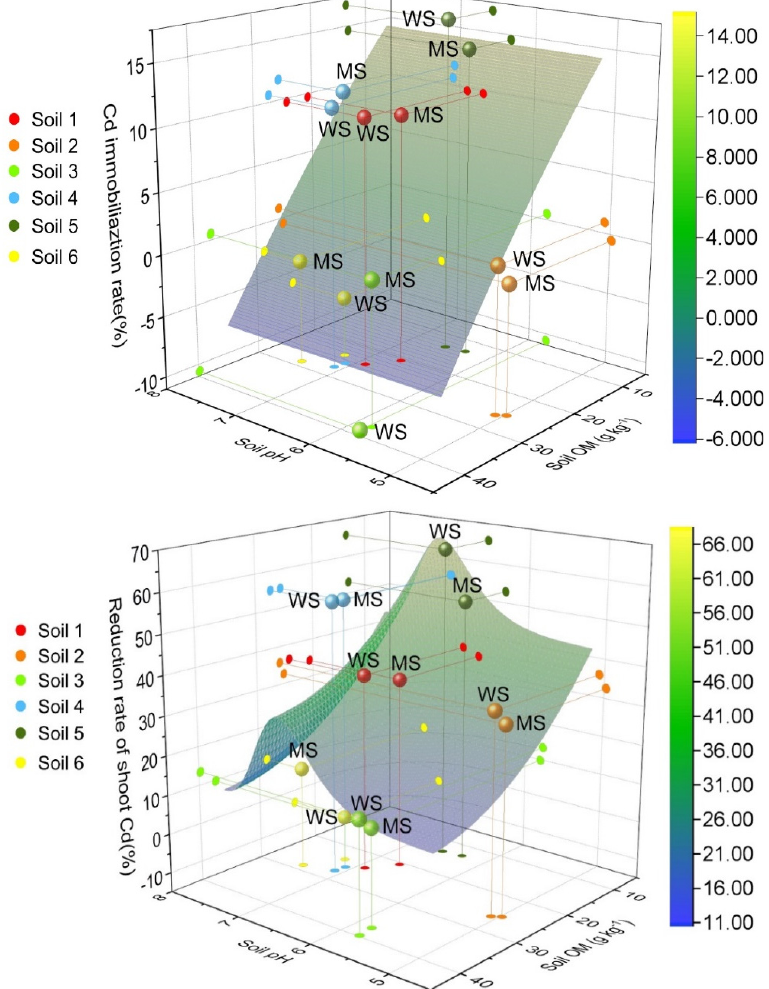
Figure 6. Response surfaces showing the interactive effects of soil pH and OM on Cd immobiliza- tion rate in six soils and reduction rate of shoot Cd by 4A molecular sieve and